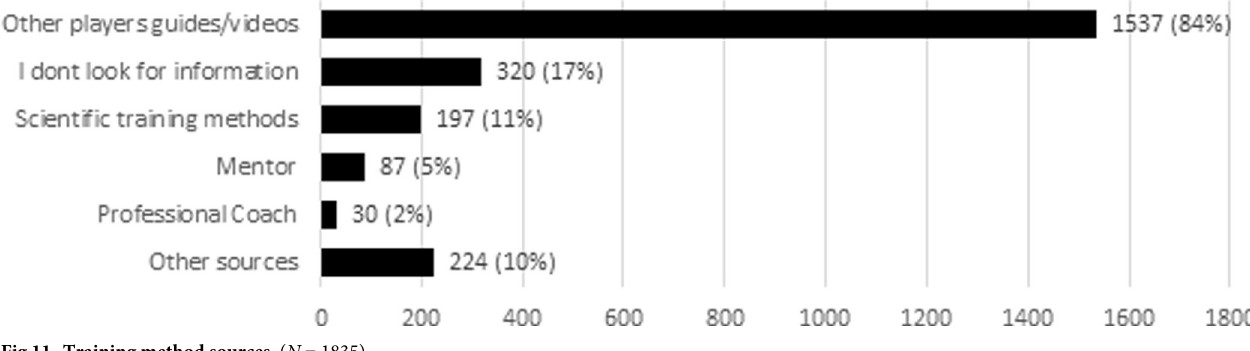
Fig 11. Training method sources. ( N =